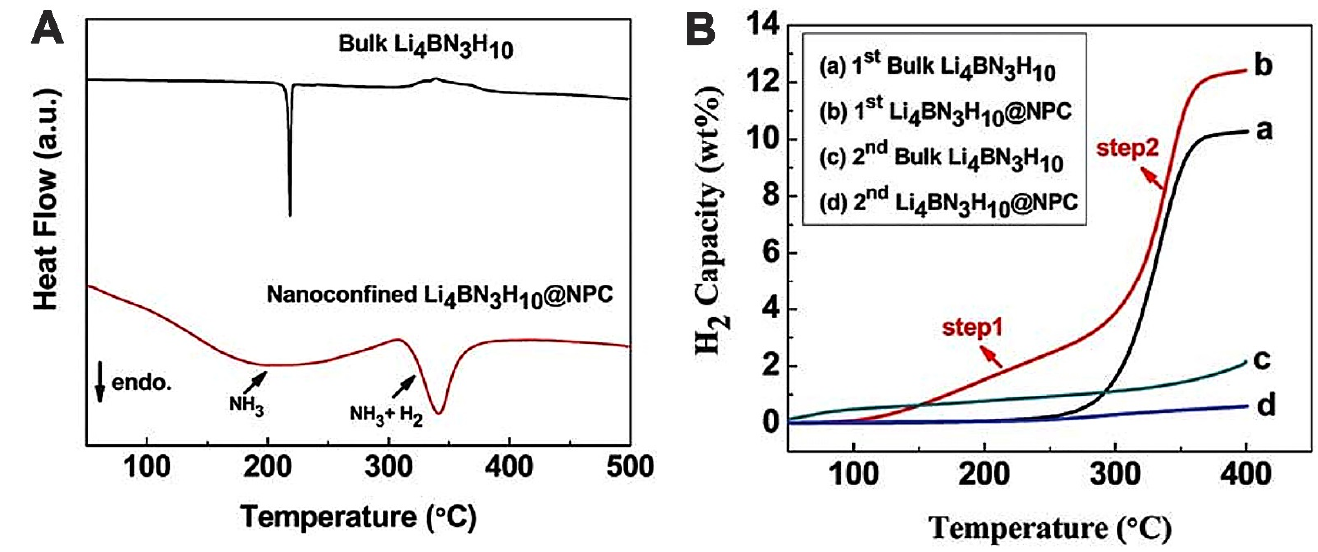
Figure 11. ( A ) DSC curves of bulk Li4BN3H10 and nanoconfined Li 4 BN 3 H 10 @NPC. The heating rate is 5 C/min. ( B ) Temperature-programmed desorption (TPD) curves of as prepared Li 4 BN 3 H 10 and pre-melted Li 4 BN 3 H 10 @NPC with an initial loading of 20 wt%. (a) First desorption of prepared Li 4 BN 3 H 10 ; (b) First desorption of pre-melted Li 4 BN 3 H 10 @NPC; (c) Second desorption of rehydrided Li 4 BN 3 H 10 ; (d) Second desorption of rehydrided Li 4 BN 3 H 10 @NPC. Note that some of the desorbed gas is NH 3 , especially in the bulk sample (a). Figure is reprinted with permission from ref. [191].